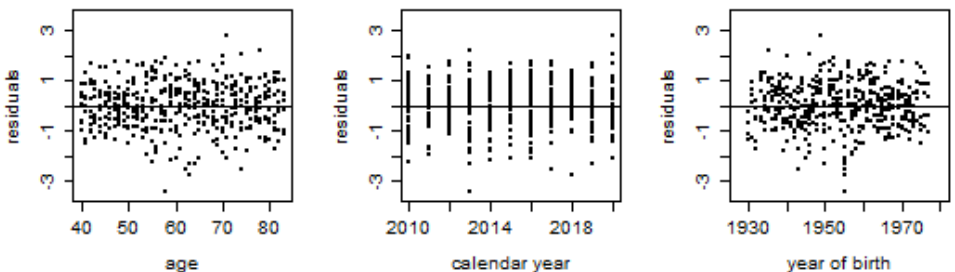
Figure 7. LC Deviance Residuals from the Fitted Model to the Ghana Pension Population for Ages 40–84 and the Period 2010–2020.